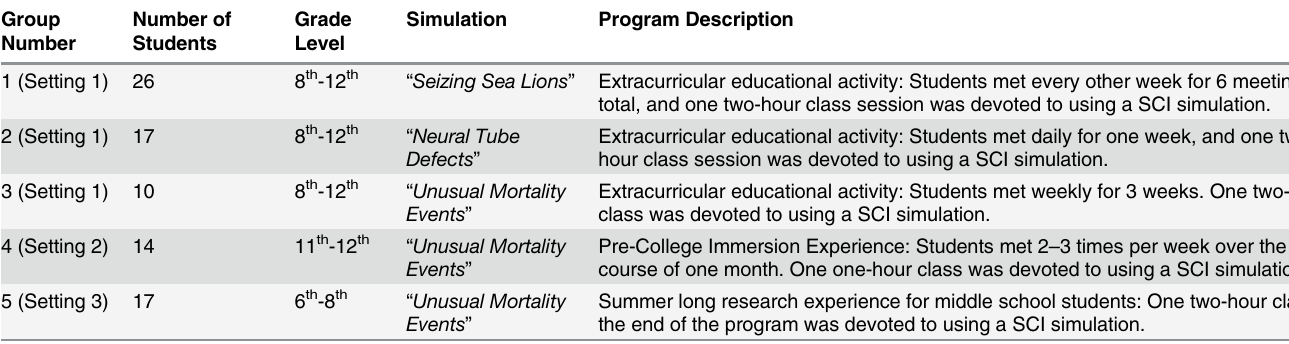
Table 1. Description of fi ve groups who utilized SCI simulations. Group Number of Number